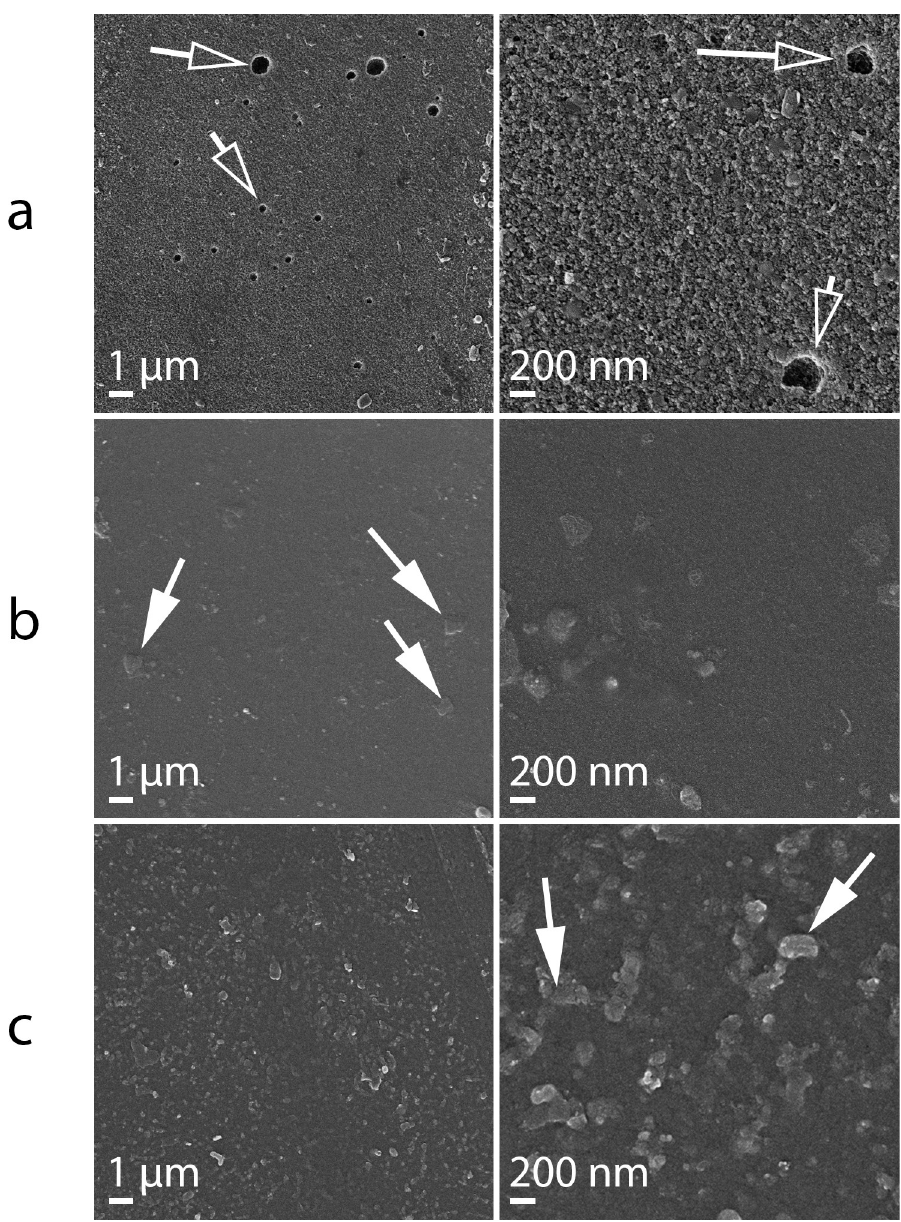
Fig 2. FE-SEM micrograph of the synthesized membranes. (a) CS, (b) PVA and (c) PVA:CS membranes. Open arrows indicate the pores, and solid arrows the PVA crystals. respectively. The CS and PVA:CS membranes displayed higher conductivity values than PVA membranes. These results are totally in line with IEC data, where the highest values of IEC were obtained with CS-based membranes, due to ionic interactions between the amino group of CS’s backbone and sulphonic group of cross-linking agent that increases the transport of protons [25]. Oxygen diffusion across membrane. Oxygen diffusion through the membrane is a key factor in MFCs operation, since anoxic conditions are necessary in the anodic chambers to